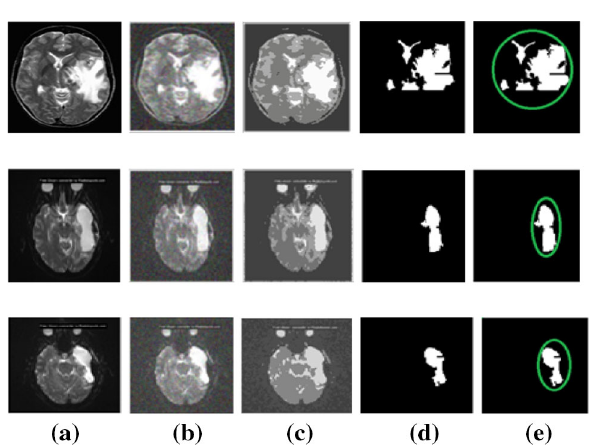
Fig. 3 Observational results of an image a original images, b prepro- cessed images, c region segmentation tumor image, d extracted tumor images, e area of extracted tumor region